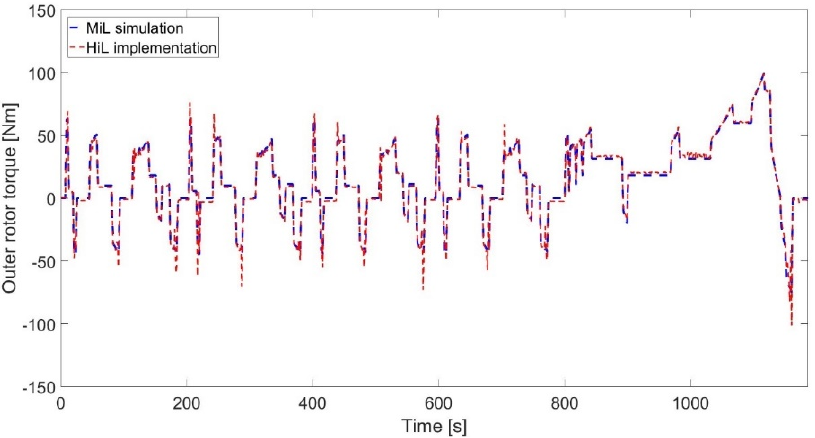
Figure 15. HiL (experimental) vs. MiL agreement results for the outer rotor torque, LPF-based EMS.